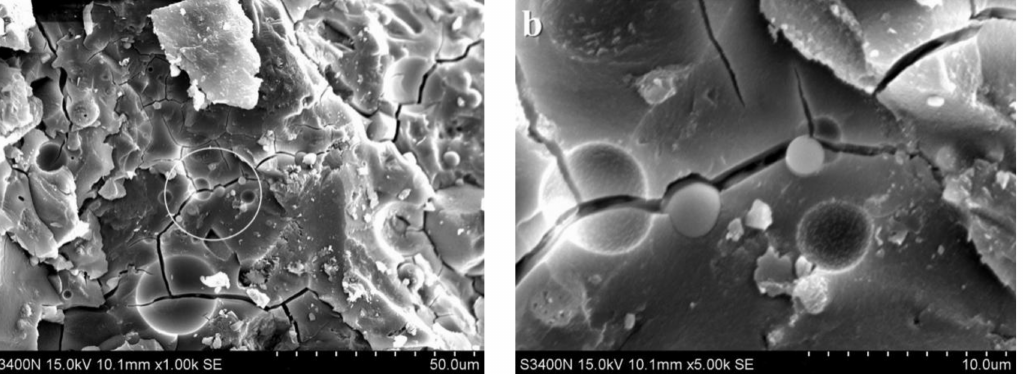
Figure 10. SEM images of alkali slag cement sand substituted with 50% fly ash at hydration ages of 3 d.